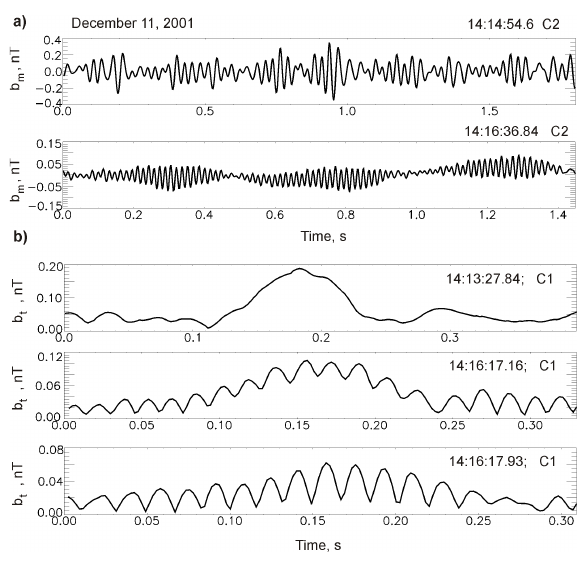
Fig. 9. (a) The magnetic field variations ( B m ) in the whistler wave packets observed in the same magnetic field trough. (b) Variations of wave amplitude in three different wave